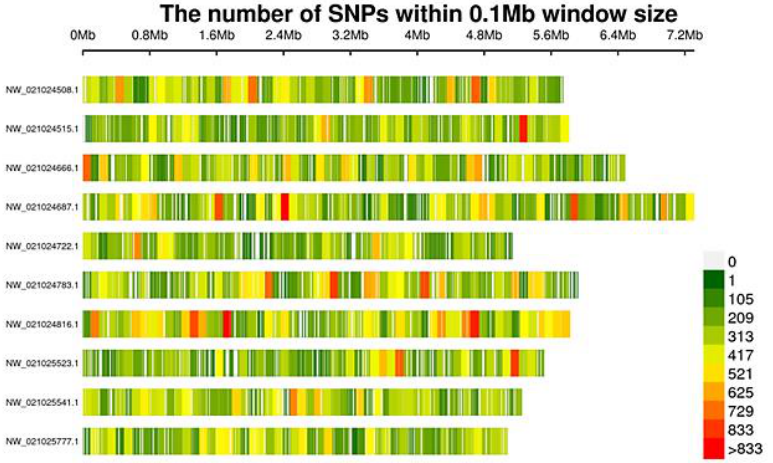
Figure 3. Distribution of SNPs on the chromosomes. The abscissa is the length of chromosomes, and each band represents a chromosome. The genome is divided according to the size of 0.1MB. The more SNPs in each window, the darker the color. Fewer SNPs are indicated in a lighter color. The darker area is the area where SNPs are